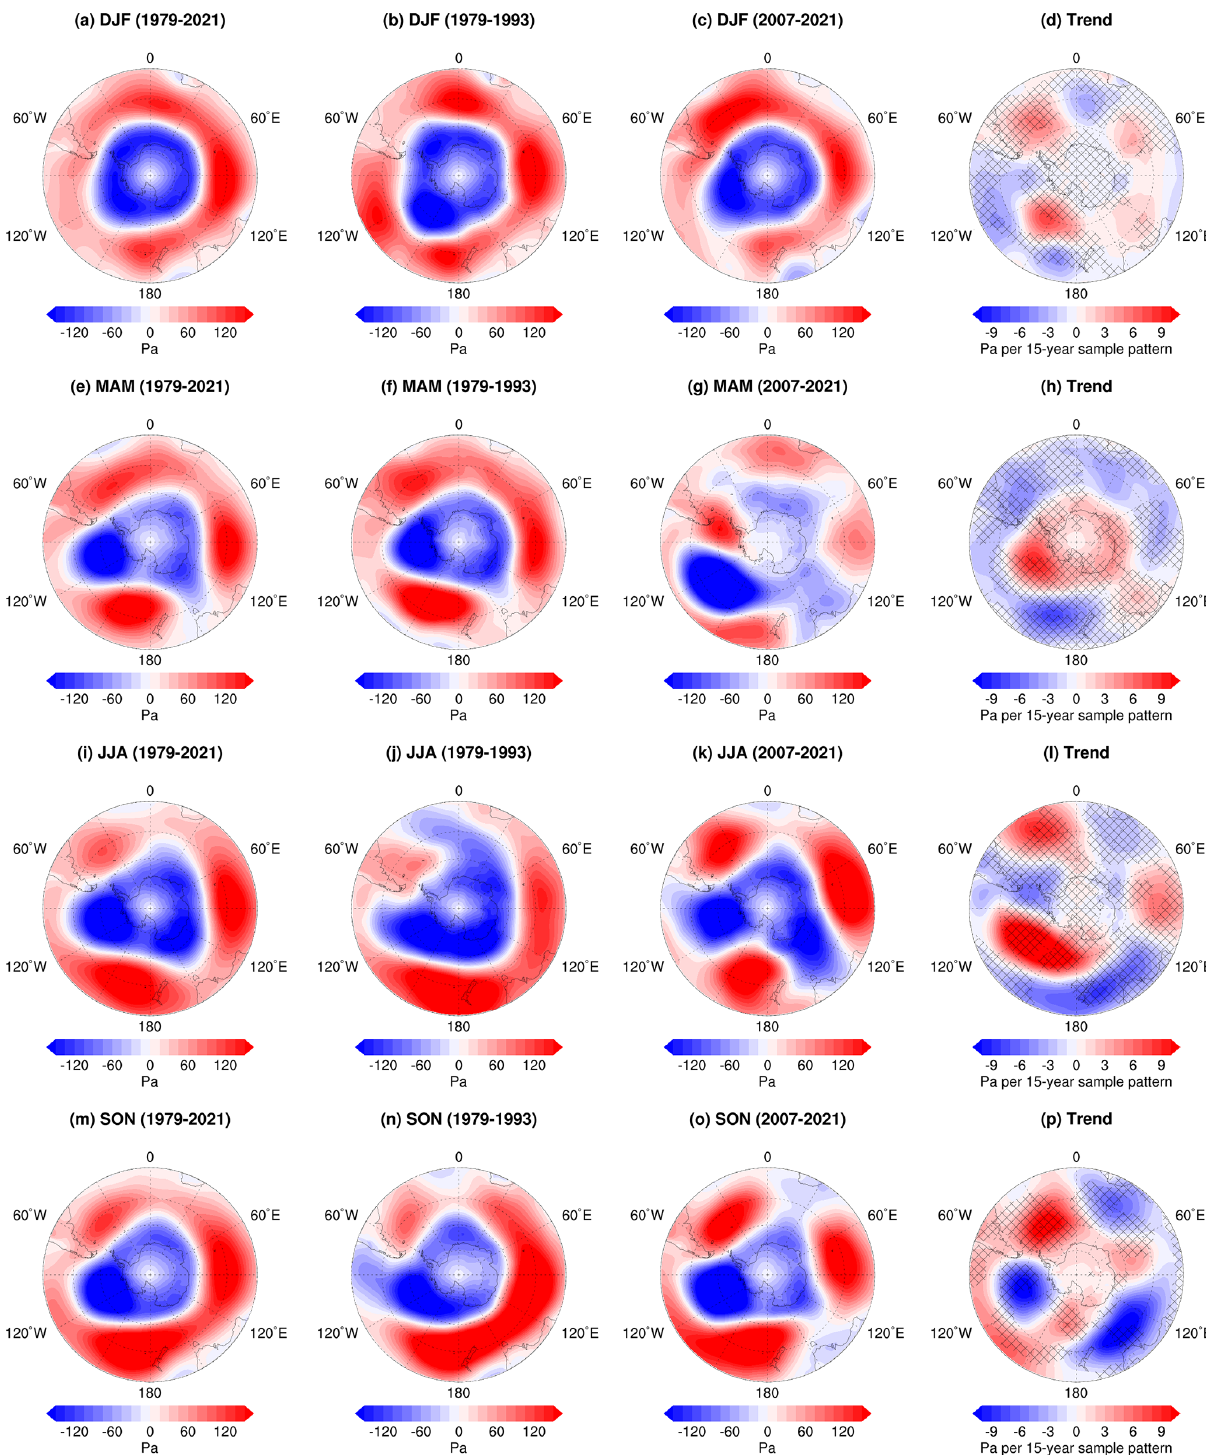
Figure 6. EOF1 of detrended seasonal SLP anomalies for (a, e, i, m) 1979–2021, (b, f, j, n) 1979–1993, and (c, g, k, o) 2007–2021, as well as (d, h, l, p) trends of running 15-year seasonal EOFs. Stippling shows regions where trend patterns are statistically significant ( p < 0 . 01).